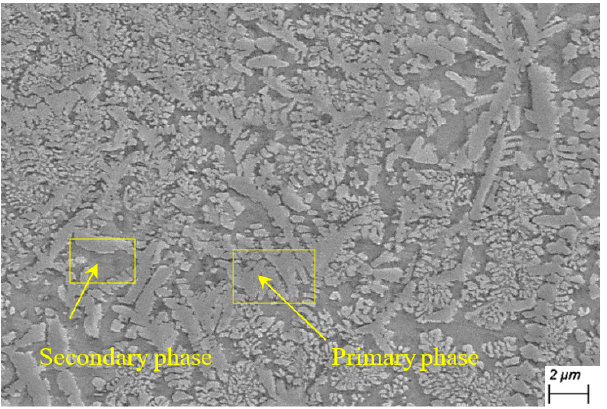
Figure 7. Primary phase and secondary phase EDS point scanning position of ultrasonic vibration Ni60 cladding layer. Table 3. Types, mass percentages and atomic ratios of elements in the crystal boundary area.